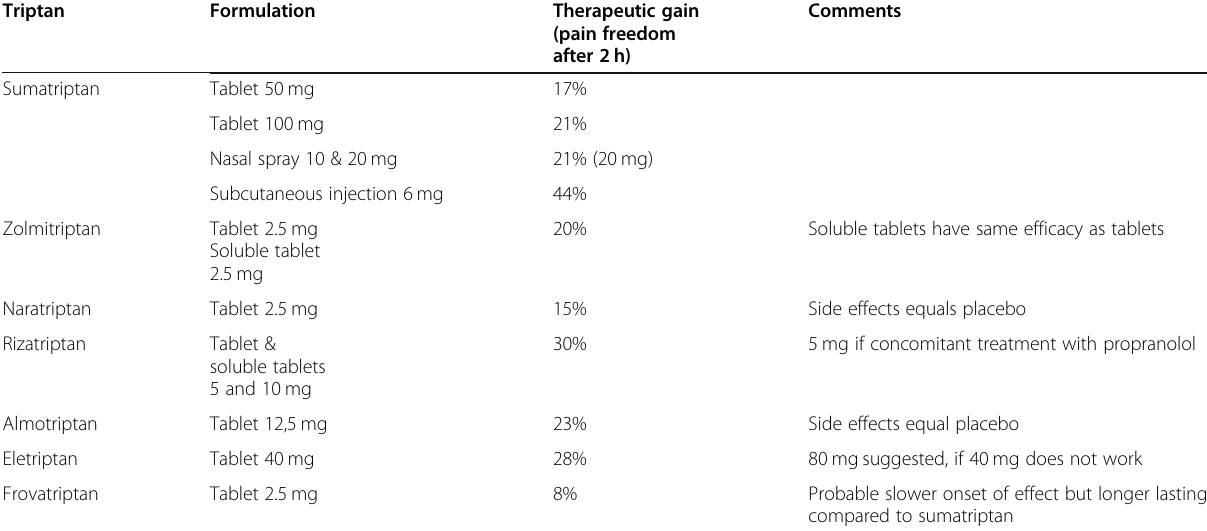
Table 7 Acute treatment of the migraine attack, second step: Triptans, which are available in Denmark (listed according to the date of marketing in Denmark). If there is an effect of the first dose of a triptan but the migraine recurs, an additional dose may be taken at least 2 h after the first dose. Therapeutic gain is the response to treatment of active substance minus the response to